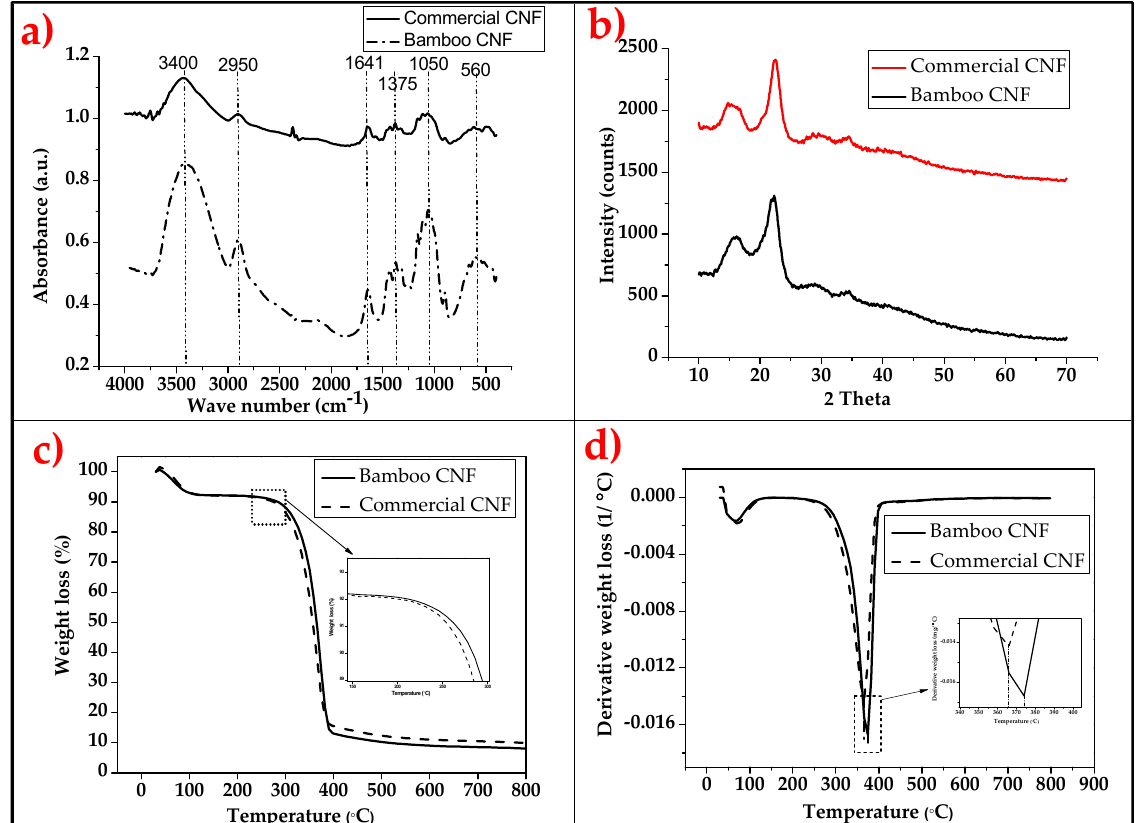
Figure 2. Results obtained from bamboo and commercial CNFs by ( a ) FT ‐ IR; ( b ) XRD; ( c ) TGA; and ( d ) DTG. Both FT-IR bands (Figure 2a) showed a wavenumber band of 3600–3200 cm − 1 , sug- gesting the stretching of hydroxide, corresponding to hydrogen bonds in the structure (-H of the –OH group). The wavenumber band at 2969 cm − 1 and 2902 cm − 1 corresponds